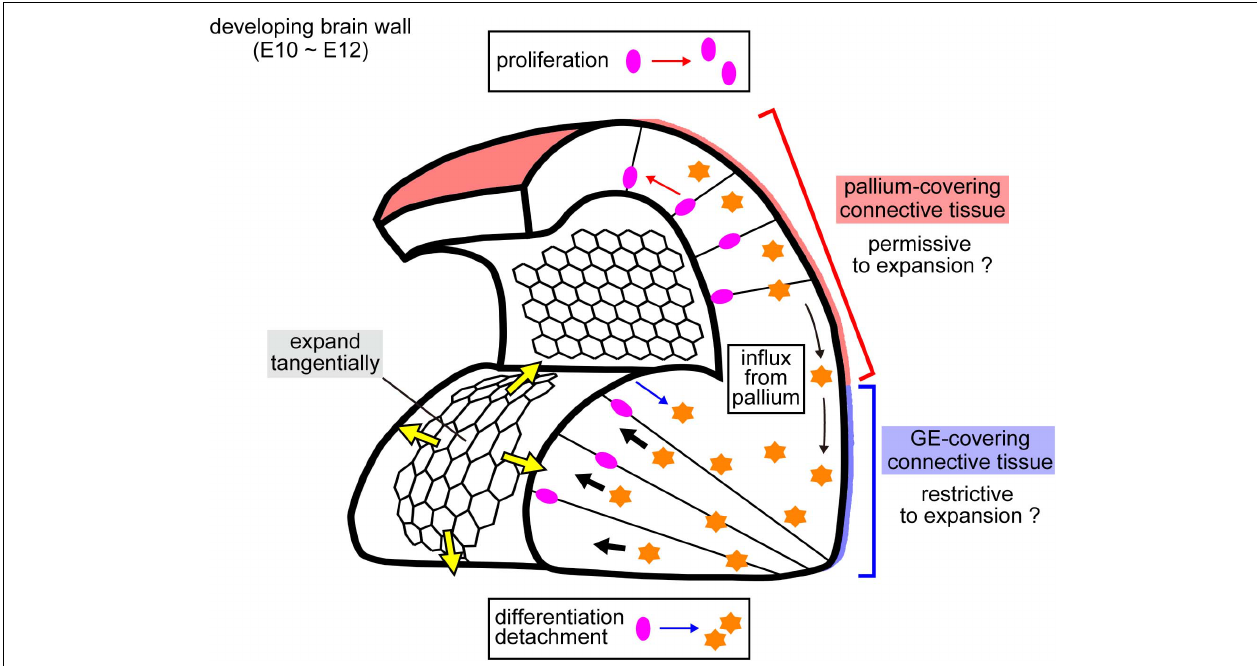
FIGURE 8 | Schematic illustration of possible mechanical factors implicated in the emergence and growth of the two distinct cerebral wall morphologies. Laser ablation onto the apical surface revealed that the convex-shaped GE apical surface showed quicker recoils of edges than the pallial apical surface ( Figure 4 ). This greater pretension on the GE apical surface (yellow arrows) could be caused by a pushing force (black arrows) arising from deeper parts. Cells detached from the apical surface (differentiating neurons and some NPCs), which seem to be more abundant in the GE than in the pallium (Smart, 1976; Smart and Smart, 1982; Pilz et al., 2013), and neurons immigrated from the pallium to the GE immigrant neurons (Saito et al., 2019), might act as an intramural stuffer. External factors would also be important, potentially playing a constricting role against lateral expansion of the cerebral wall, perhaps more strongly to the GE than to the